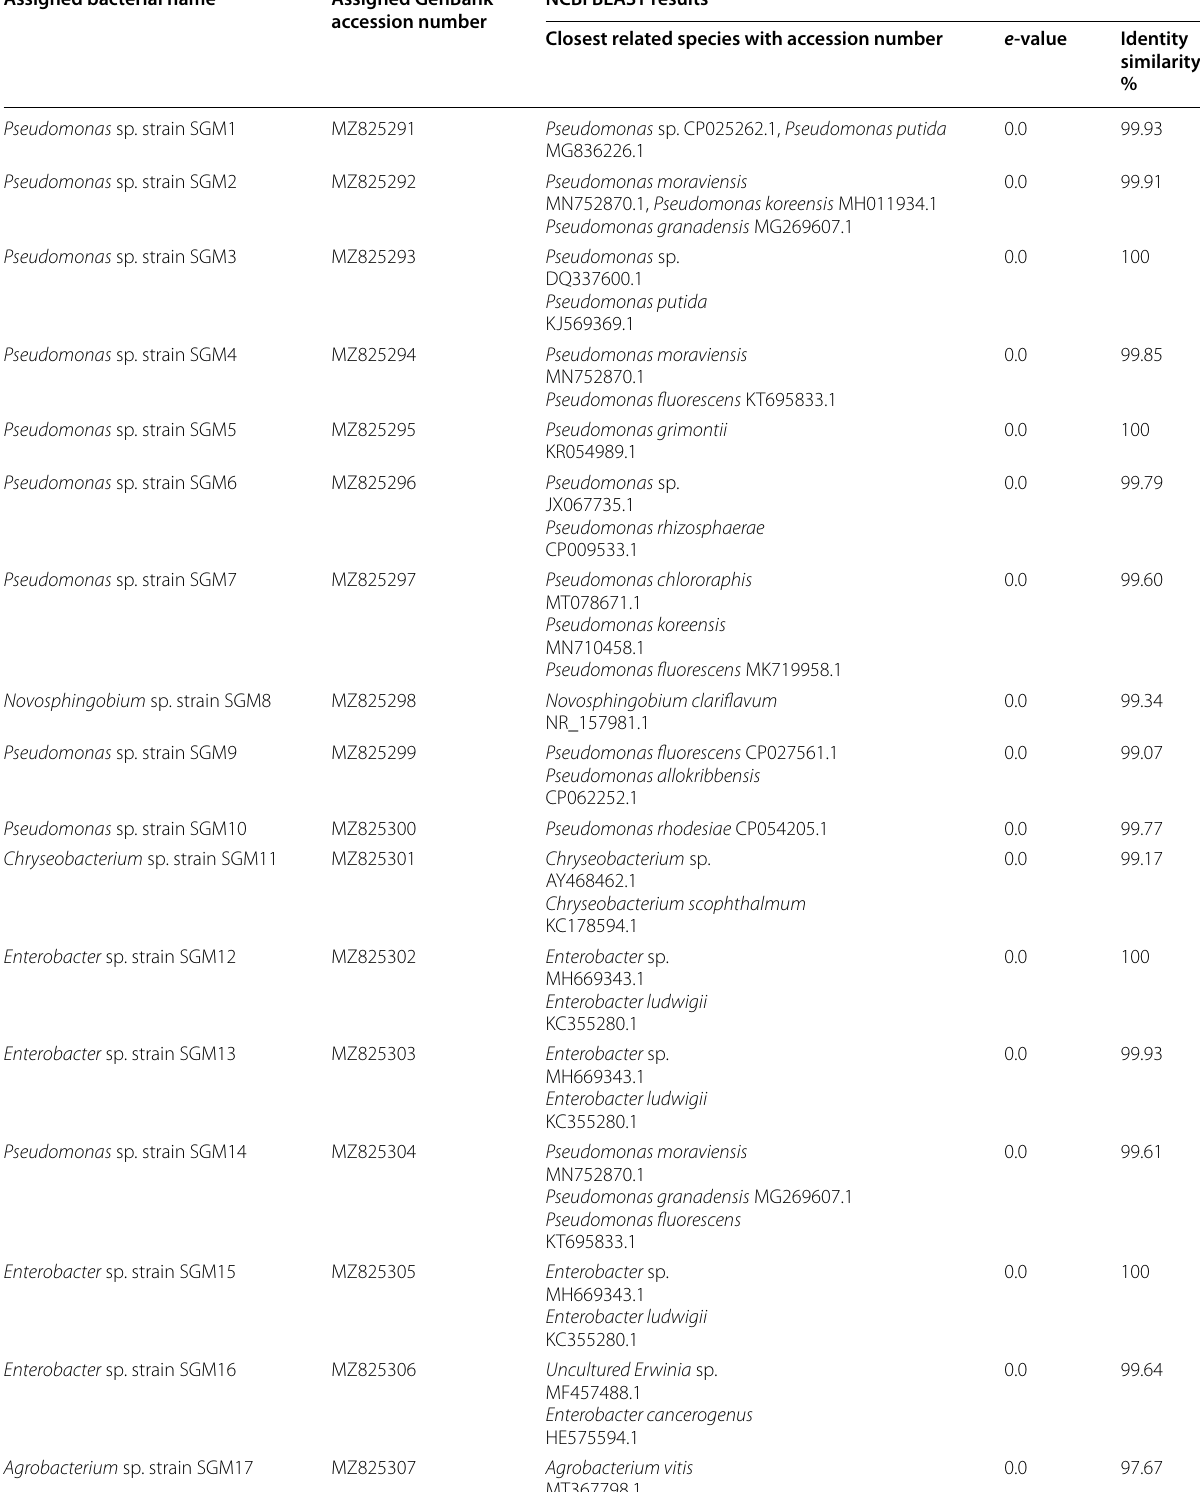
Assigned bacterial